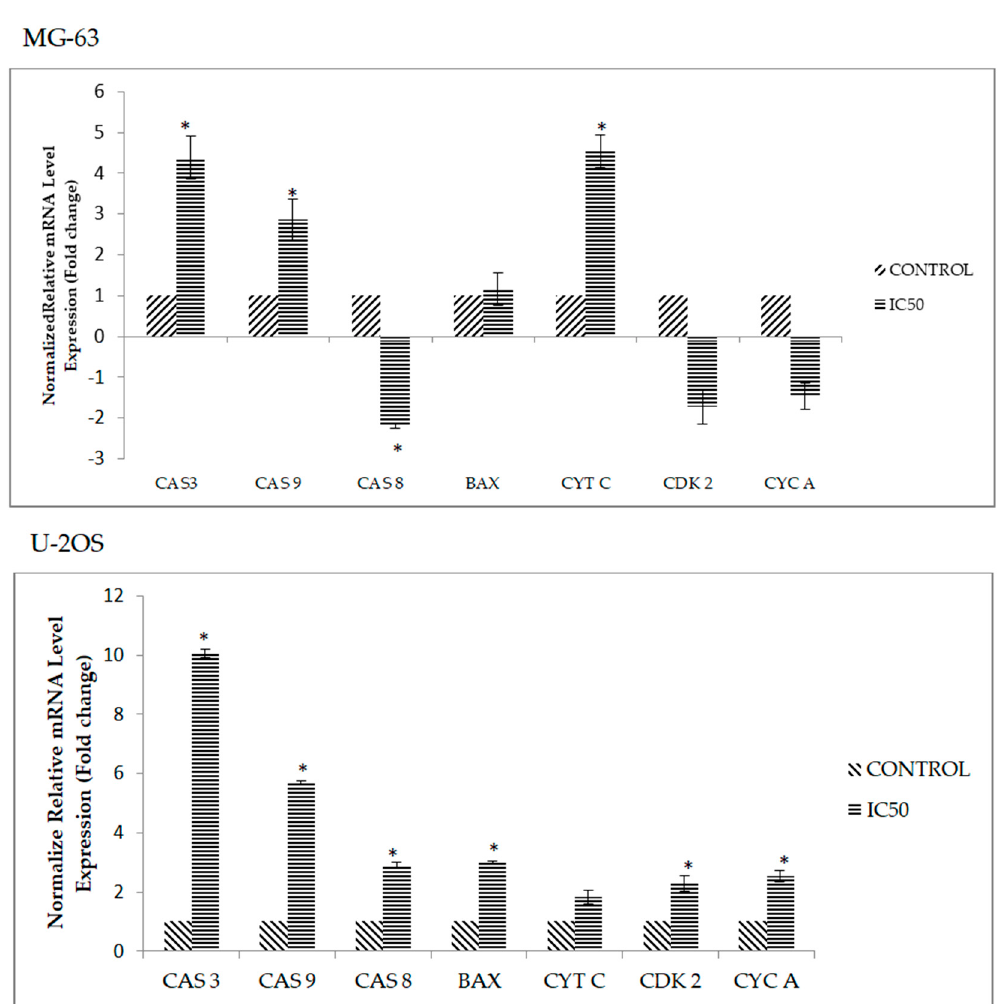
Figure 6. qPCR analysis of apoptosis and cell cycle related genes; caspase 3 (CAS 3), caspase 8 (CAS 8) and caspase 9 (CAS 9), BAX, cytochrome c (CYT C), Cdk 2 (CDK 2), cyclin A (CYC A) for MG-63 and U-2OS when treated DK1 (IC 50 ) for 48 h. Expressions of all target genes were normalized to ACTB and 18srRNA. All data are expressed as mean ± standard error mean (S.E.M). * p < 0.05 compared with corresponding controls. The significance for this assay was set at >2 fold changes, comparing between the control (untreated) group and the treated groups.